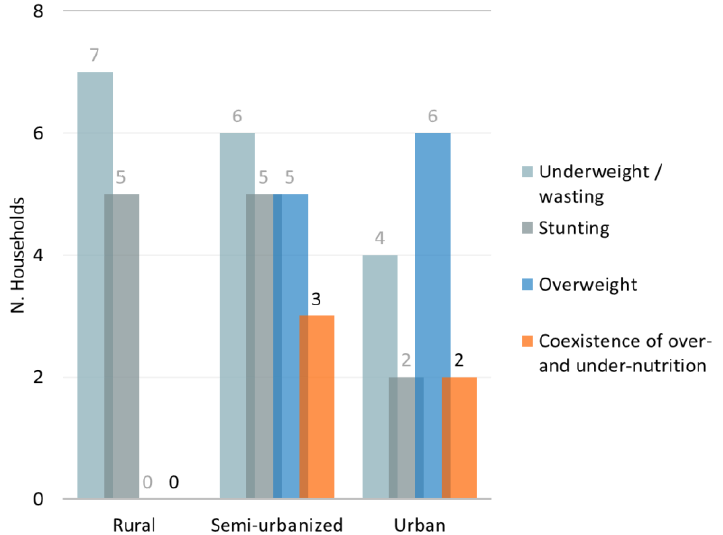
Figure 8. Double burden of malnutrition. Distribution of different forms of malnutrition (under- or overweight) within families. The number of households with at least one family member affected by underweight, stunting or overweight was reported.